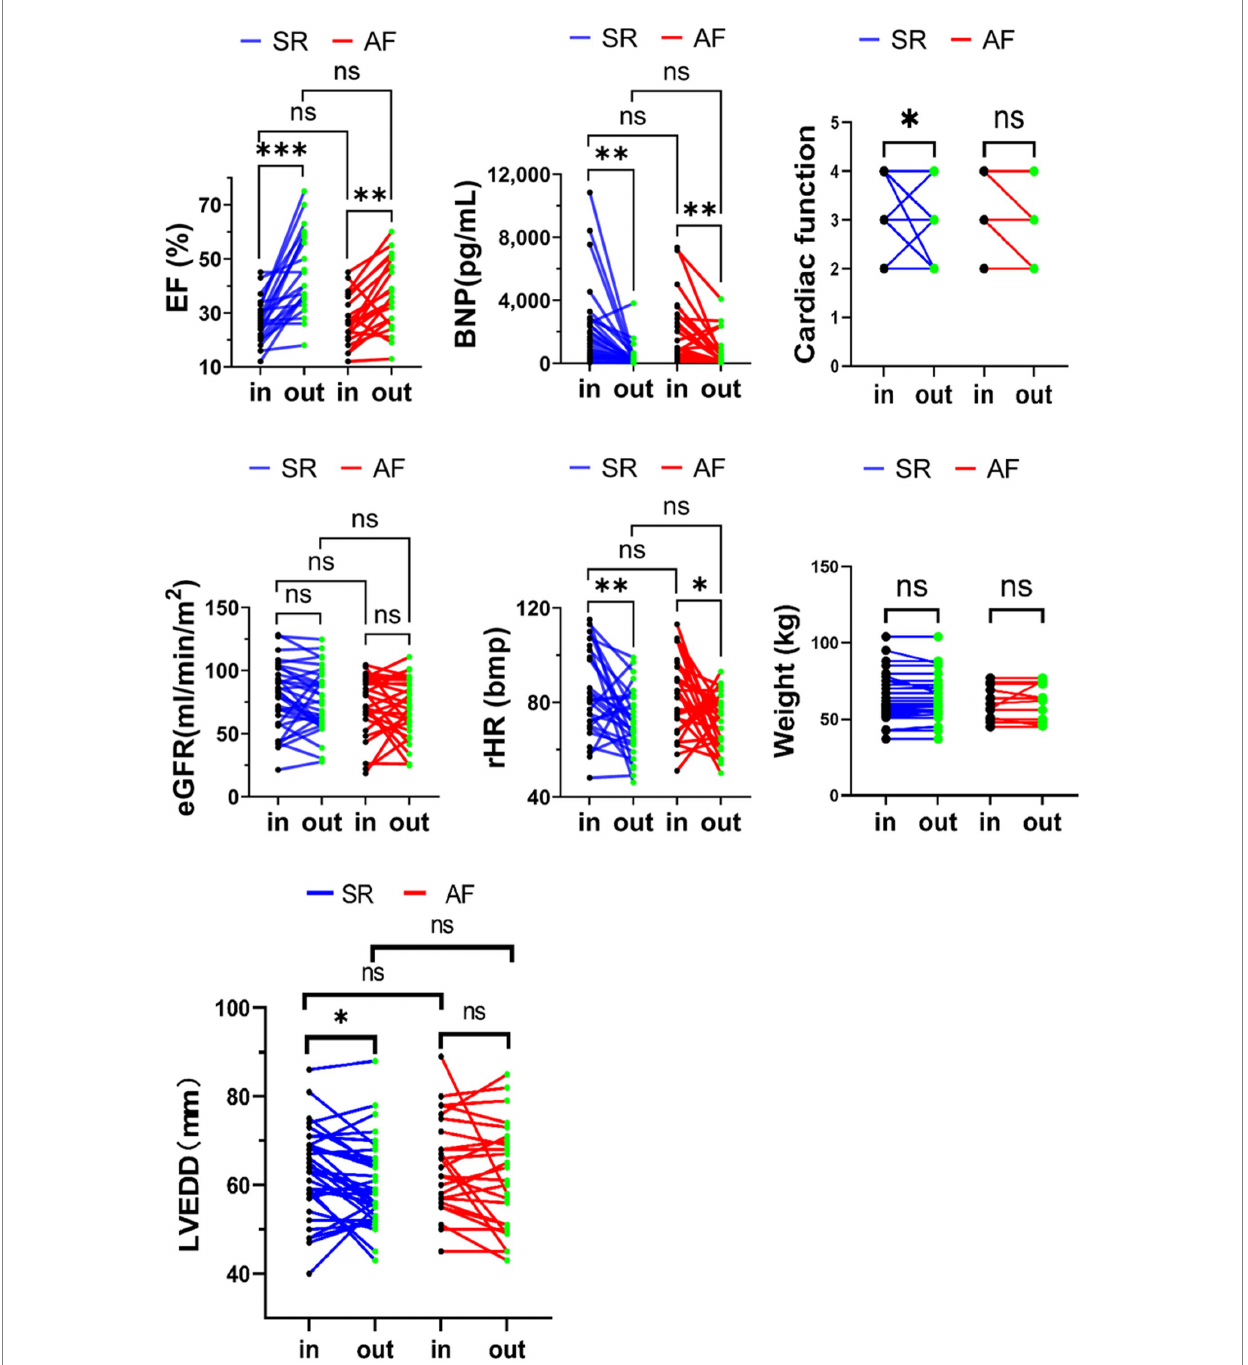
FIGURE 2 rHR, eGFR, LVEF, body weight, left ventricular end diastolic diameter (LVEDD) cardiac function and BNP variation upon admission and at discharge in advanced HFrEF patients with SR or AF. * p < 0.05; ** p < 0.01; *** p <